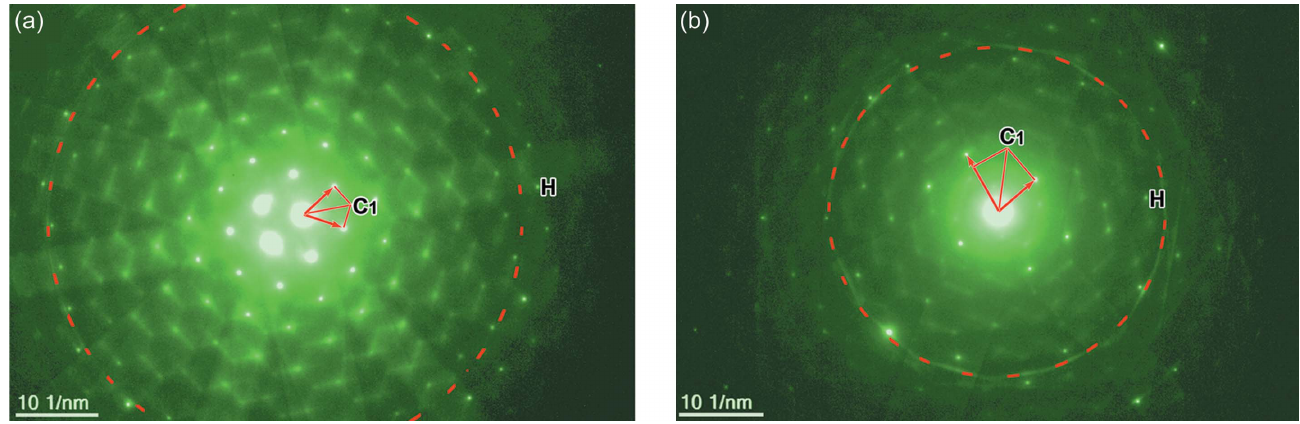
Figure 4 Effect of diffraction conditions on the unit-cell determination: ( a ) an electron diffraction pattern of silicon deviated from the exact zone-axis ½ (cid:3) 11 (cid:3) 111 (cid:8) condition by about 0.37 (cid:6) , and ( b ) a low-symmetry and high-index ½ (cid:3) 55 (cid:3) 44 (cid:3) 33 (cid:8) zone axis pattern of